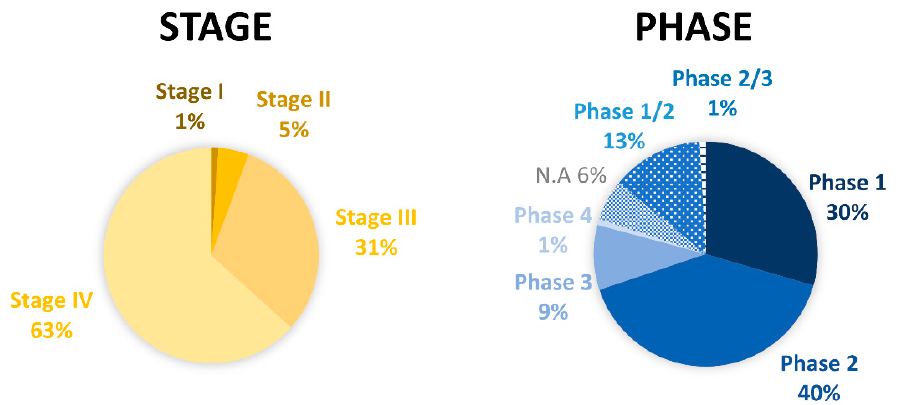
Figure 6. Graphical representation of clinical trials by melanoma disease stage and by clinical phase. Data obtained from https://clinicaltrials.gov and accessed in June 2021.